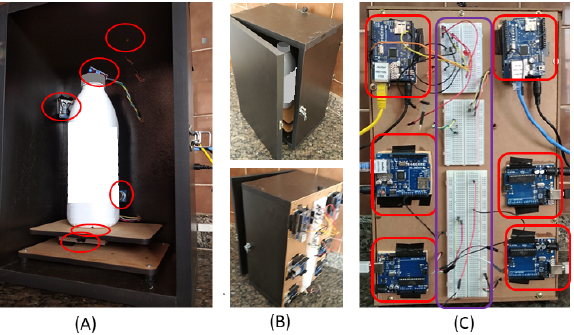
Figure 13. Front, perspective and rear view of cabinet container with sensors and agrochemical